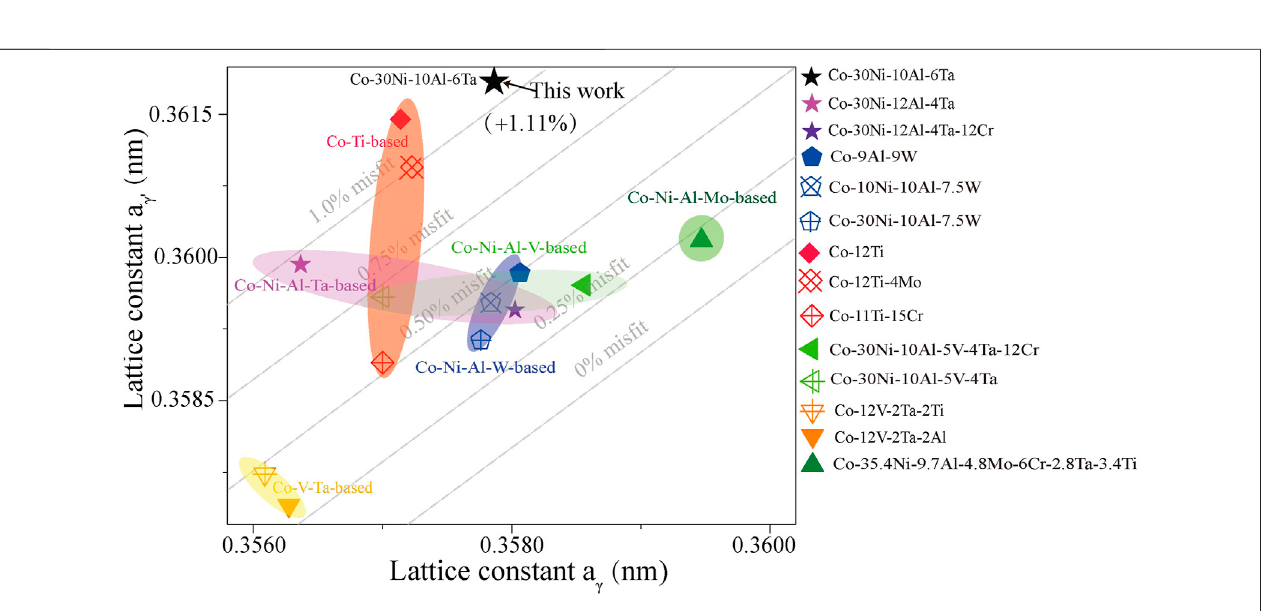
Figure 8 is a graph showing the relationship between yield strength and temperature of this alloy. In this study, part of Co-Ni-Al-V- based (Yuechao Chen et al., 2019), Co-Ni-Al-Mo-based (Makineni et al., 2015c), Co-Al-W-based (Suzuki et al., 2007), Co-Ti-based (Zenk et al., 2017), and Ni-based (Sims et al., 1987) polycrystalline superalloys are listed as comparative alloys. What can be seen from